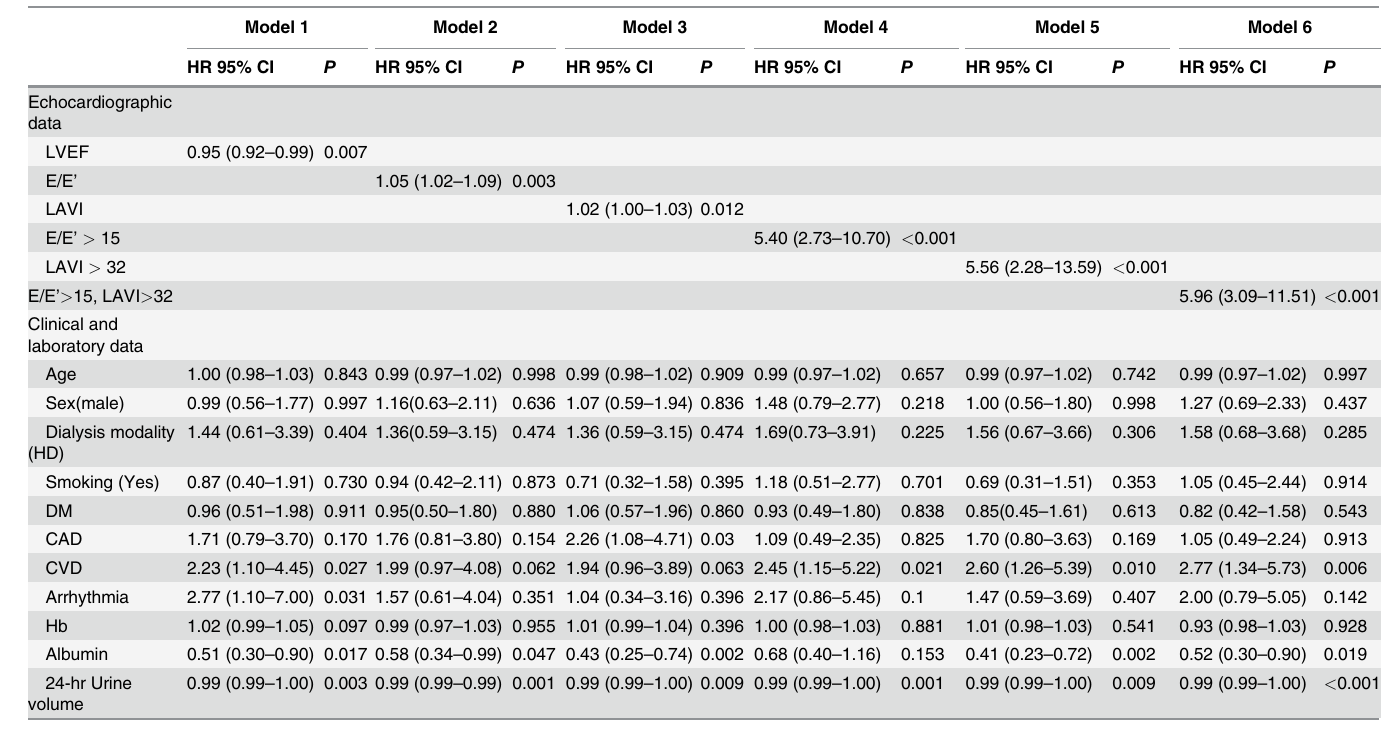
Table 7. Multivariate Cox proportional hazards regression analysis for CV